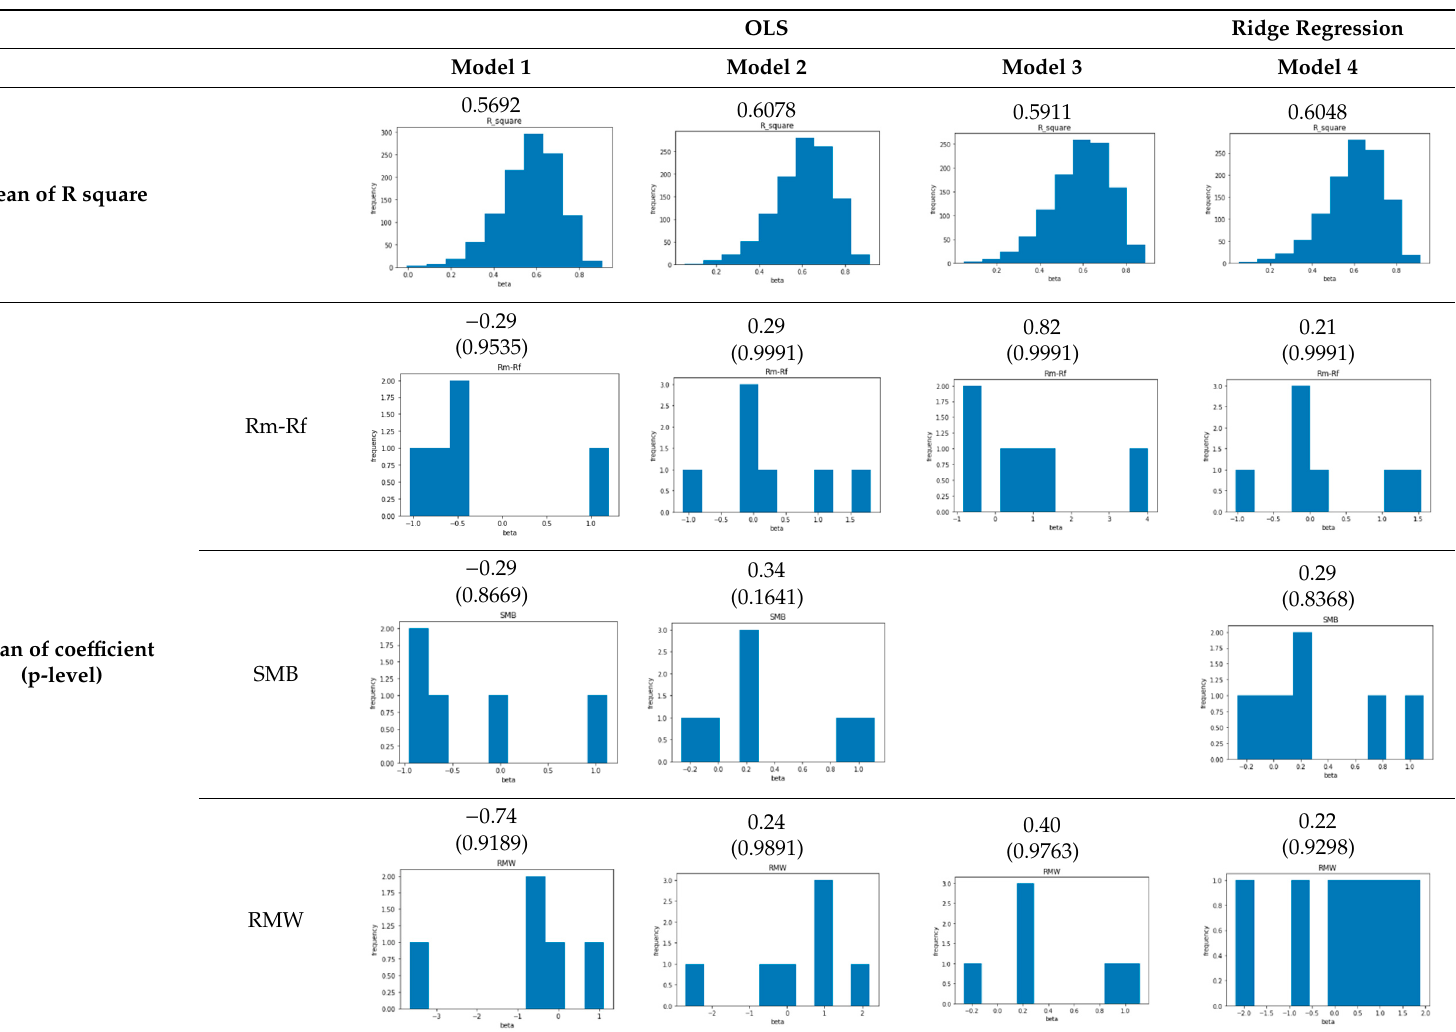
Table 2. R square mean, coefficients’ mean and p-level for four models.